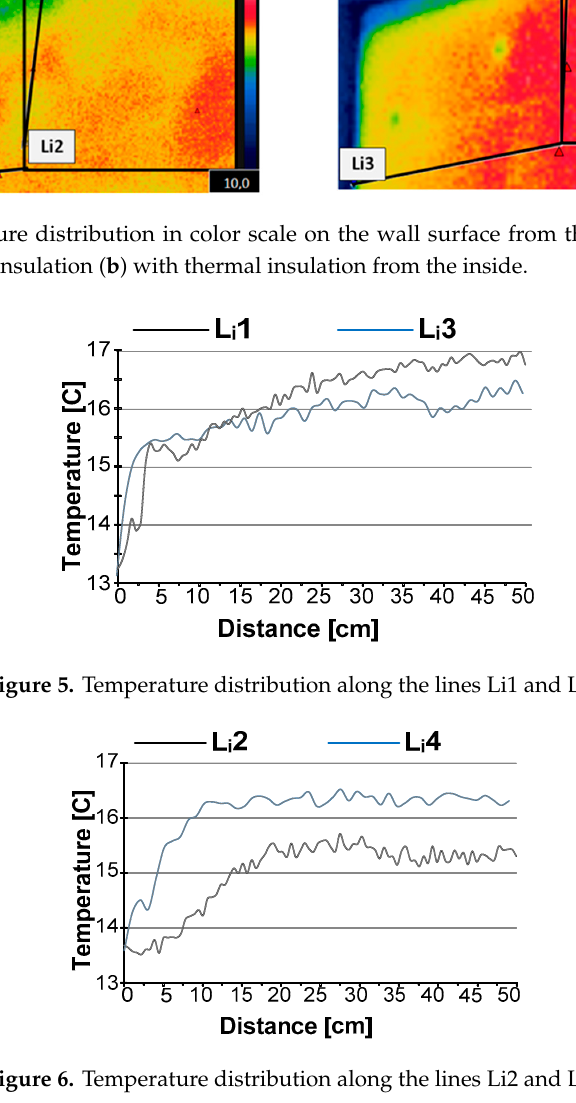
Figure 6. Temperature distribution along the lines Li2 and Li4.